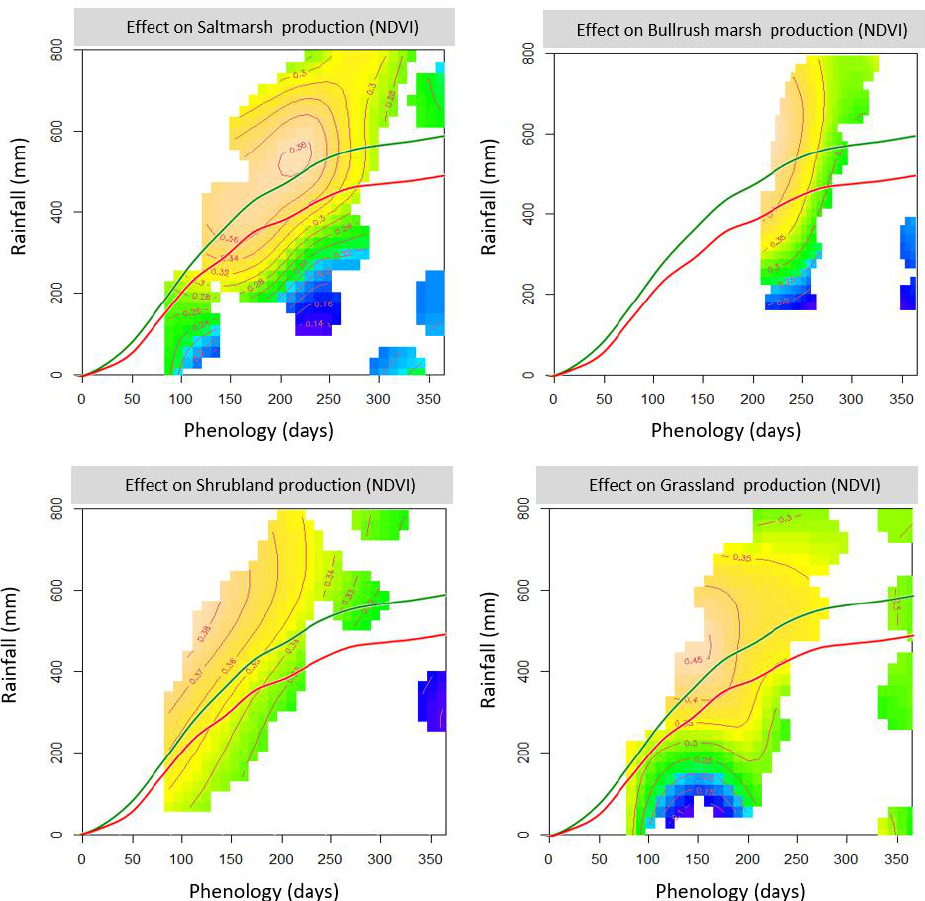
Figure 4. Bi-dimensional effect plots describing the joint effect of phenology (time of the NDVI peak; x-axes) and water availability (rainfall accumulated until the phenological peak; y-axes) on the production of four different vegetation types. The effects displayed in the graph include some of the main effects of both variables and their interaction. Note that the color palette varies among graphs, i.e., the same color does not necessarily indicate the same range of production values in all graphs, and information on production values must be extracted from the contour lines. Ranges of production values shown by contour lines are: 0.14–0.36 for saltmarsh, 0.2–0.4 for bulrush marsh, 0.2–0.38 for shrubland, and 0.1–0.45 for grassland. Green and red lines indicate the observed (1996–2000) and predicted values (MIROC model: 2041–2070) of accumulated rainfall at all possible values of phenology (daily cumulative values, averaged across the aforementioned time series).